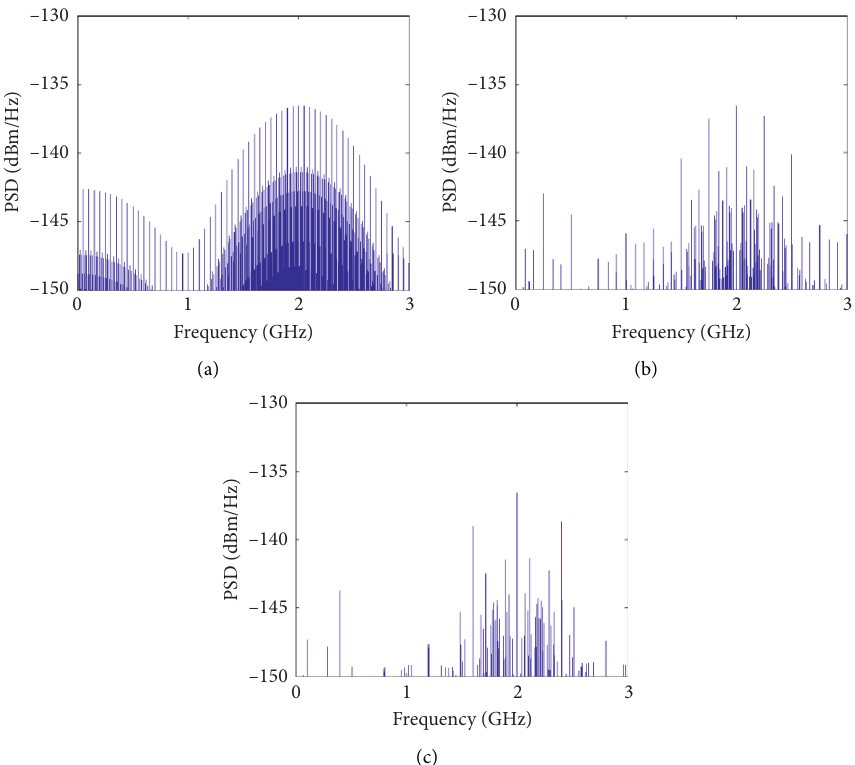
Figure 2: The PSD of TH-PPM UWB ( Np � 10). (a) PRF � 10MHz, Np � 10. (b) PRF � 50MHz, Np � 10. (c) PRF � 80MHz, Np � 10.